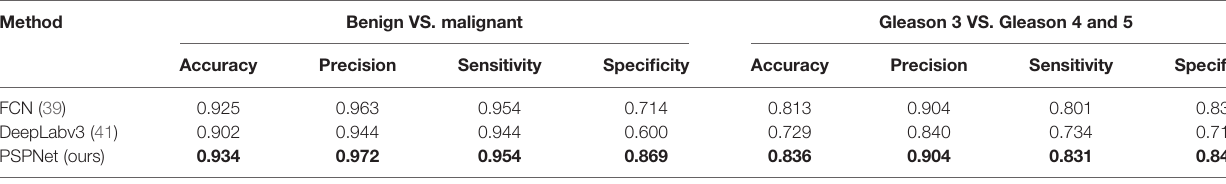
TABLE 4 | Core-level Gleason grade prediction of different methods.